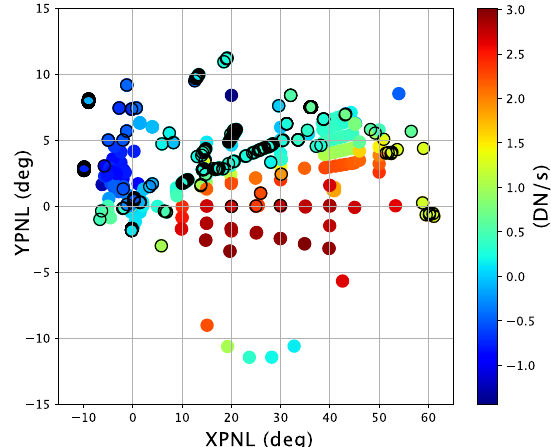
Fig. 12 Stray light intensity (log[DN/s]) of ONC-T for spacecraft attitudes taken from June 27, 2019 to December 26, 2020. Black circles show observations made with a long exposure (> 100 s). XPNL and YPNL represent the solar incidence angle on the spacecraft’s X and Y panel,